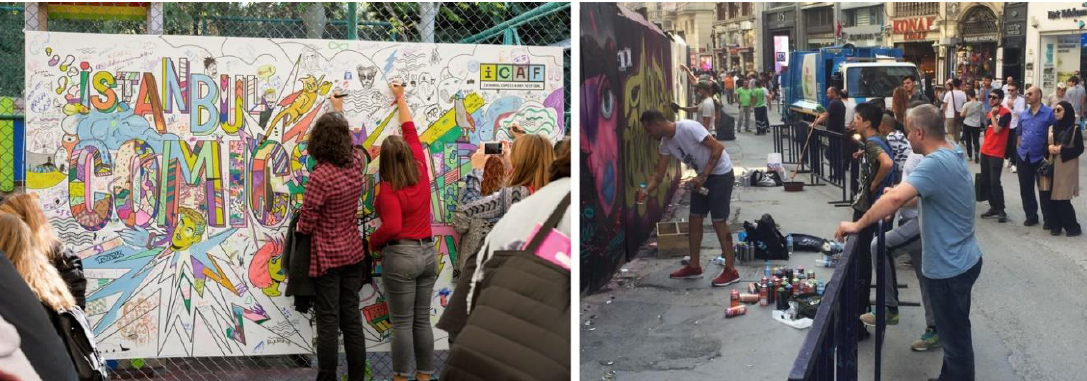
Figure 3 Istanbul Comics & Art Festival provided some experimentation platforms (i.e., outdoor workshops and exhibitions) in public space (left), and the graffiti artists drawing under the gaze of people on the street (Source: URL-6; personal archive,